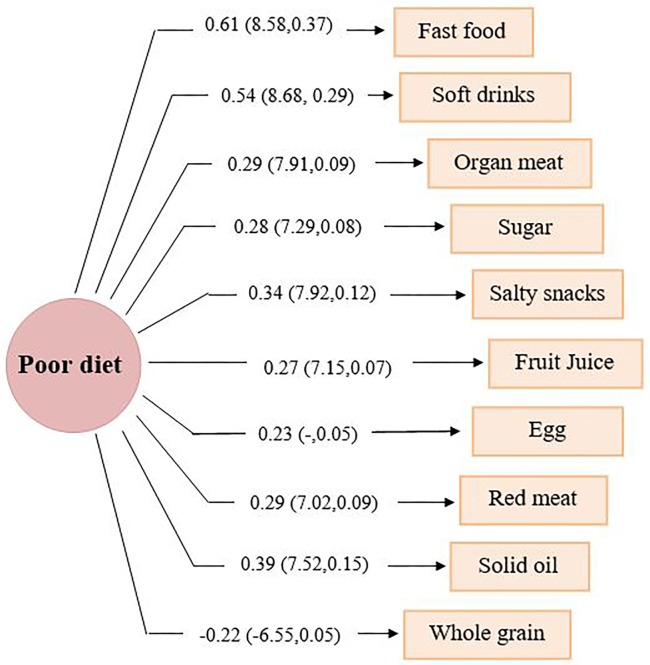
Measurement model of poor dietary pattern: A CFA model based on 50% random sample data (n = 2782).Fit indices of poor diet CFA model: χ2 = 34.43, DF = 20, χ2/DF = 1.72, RMSEA = 0.016, SRMR = 0.013, GFI = 0.99, CFI = 0.99, IFI = 0.99, NFI = 0.98. The standardized factor loadings (Z-statistics for testing adequacy of explained variance of food groups by poor diet construct, squared multiple correlation of each food group predicted by construct) are reported on pathways.